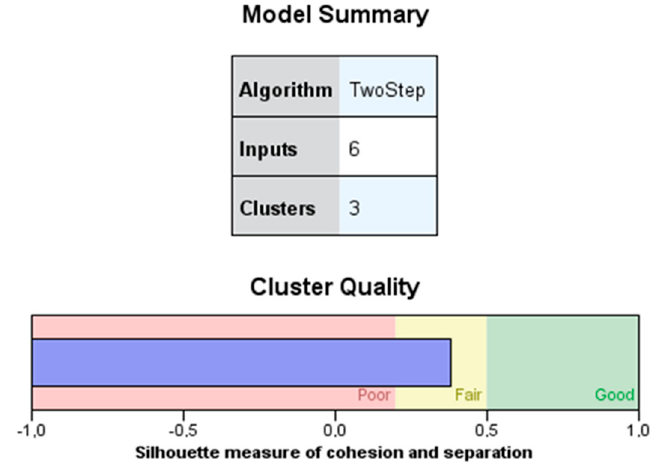
Figure 2. Model summary and cluster quality graph. Figure 3 illustrates the variables evaluated in the rows and the clusters in the columns, showing three distinct profiles: